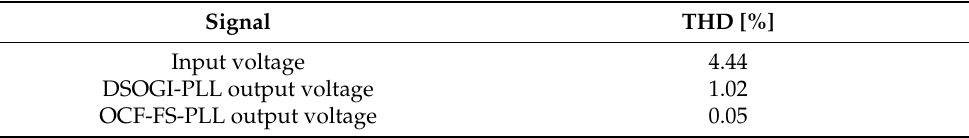
Table 3. Filtering performance of the OCF-FS-PLL and DSOGI-PLL under 5th, 7th, 11th, 13th, 17th, and 19th